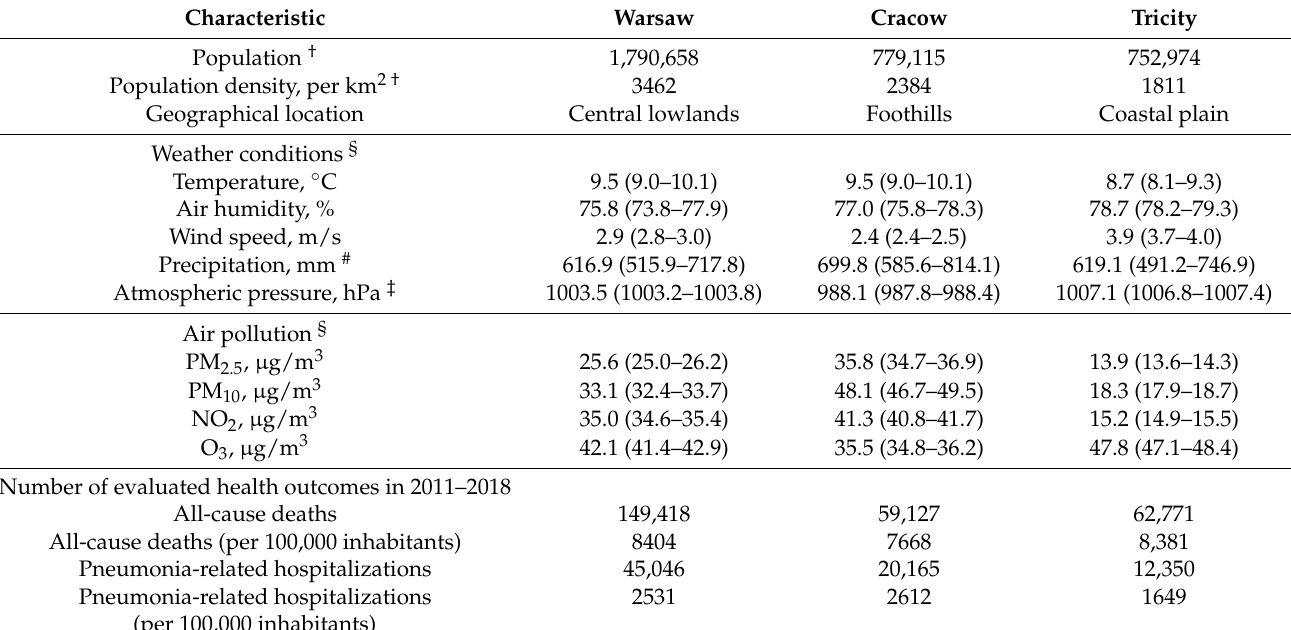
Table 1. Characteristics of the analyzed agglomerations in Poland.